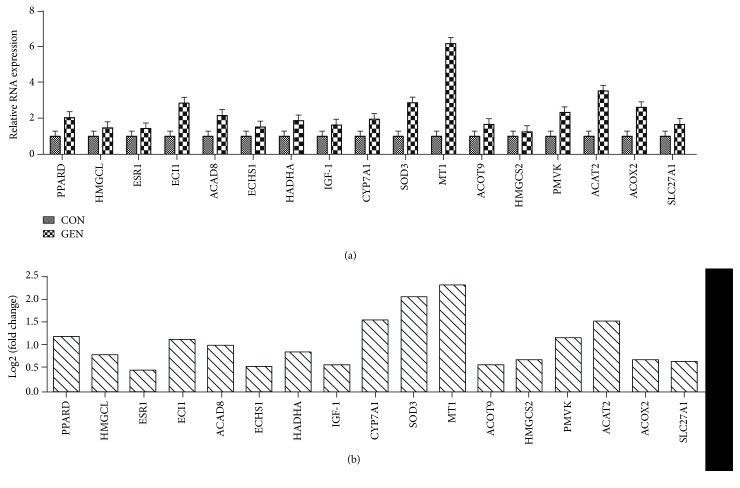
(a) The relative RNA expressions of genes in the chick liver as determined by using qPCR (n = 6). (b) The log2 (fold change) of gene expression abundance (GEN vs. CON) as determined by using RNA-Seq (n = 4).